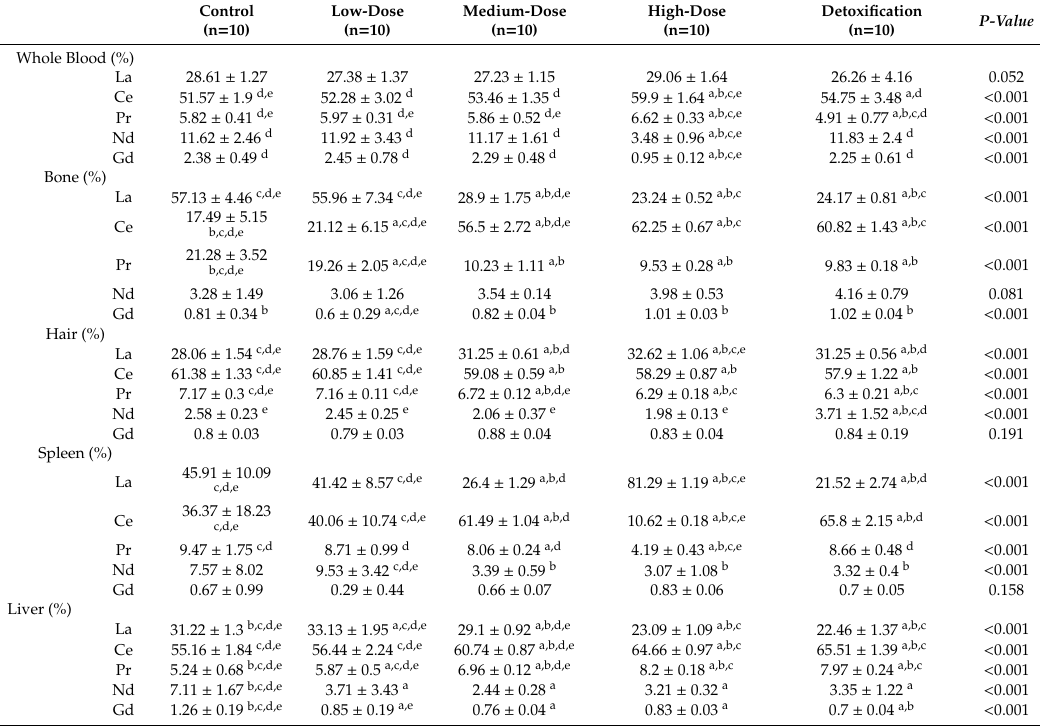
Table 2. The relative element abundance of five REEs in di ff erent tissues and organs from rats in di ff erent groups.